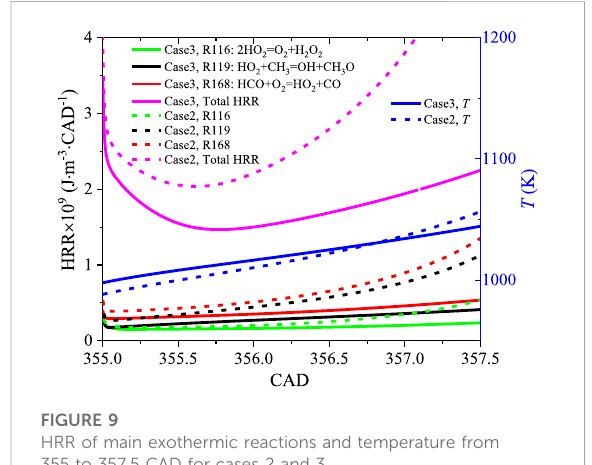
FIGURE 9 HRR of main exothermic reactions and temperature from 355 to 357.5 CAD for cases 2 and 3.